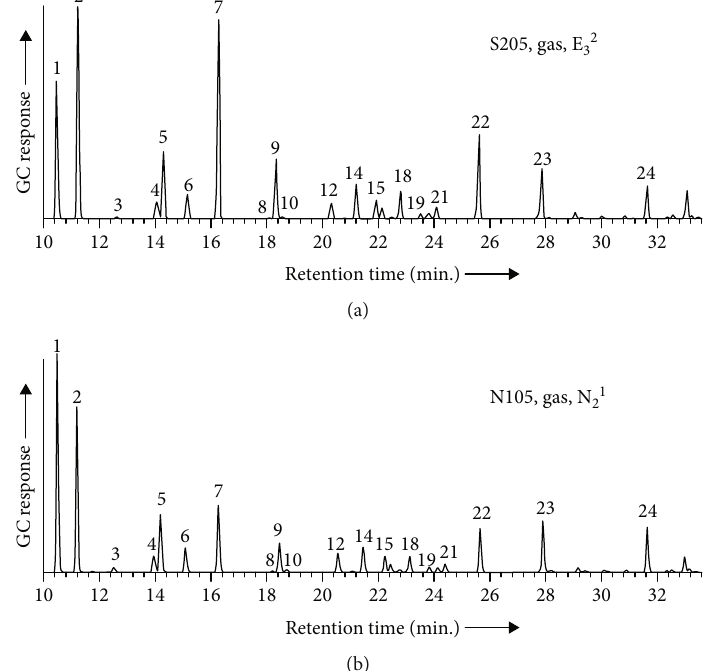
Figure 3: Representative gas chromatogram of light hydrocarbons (C the corresponding light hydrocarbons are listed in Table 2.